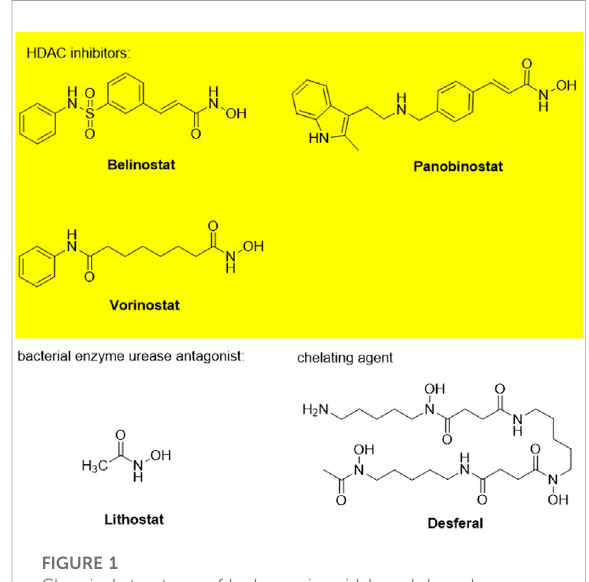
FIGURE 1 Chemical structures of hydroxamic acid-based drugs have been approved for the clinic or in clinical